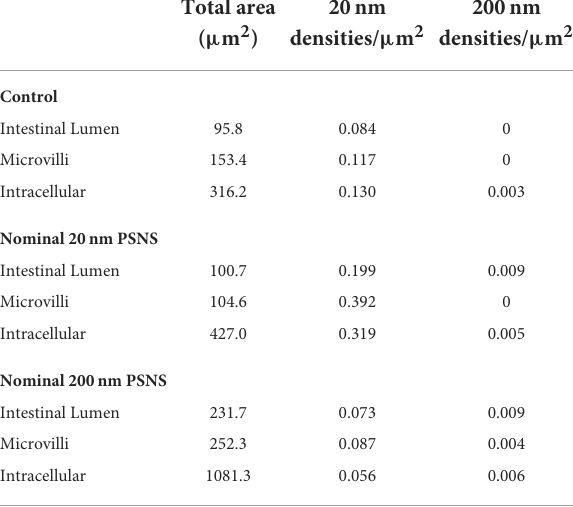
TABLE 2 Accumulation of densities, visualized by electron microscopy, in the jejunum of mice after ingestion by gavage of aqueous vehicle alone (Control), and nominal 20nm and 200nm